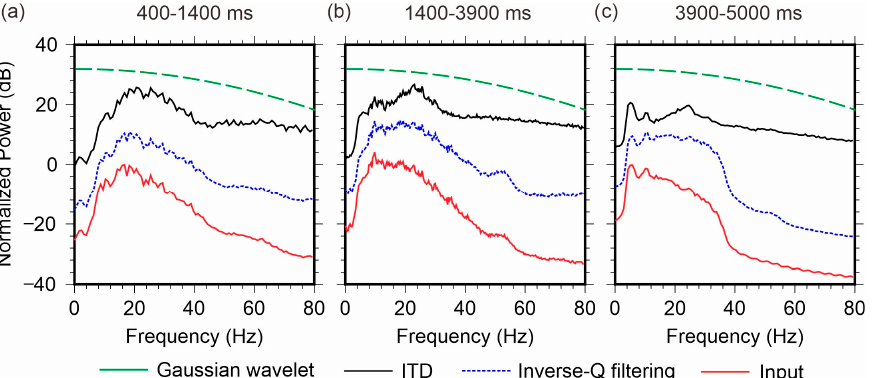
Figure 13. Power spectra of the data before (red lines) and after (black and blue lines) compensation within reflection-time ranges: ( a ) 400–1400 ms, ( b ) 1400–3900 ms, and ( c ) 3900–5000 ms. Black solid lines indicate the spectra measured for ITD compensation and blue dotted lines are the spectra after inverse- Q filtering. Identical green dashed lines are the spectrum of the Gaussian wavelet (Figure 10c). Please note that the spectra were shifted up or down to separate the curves for a better view.